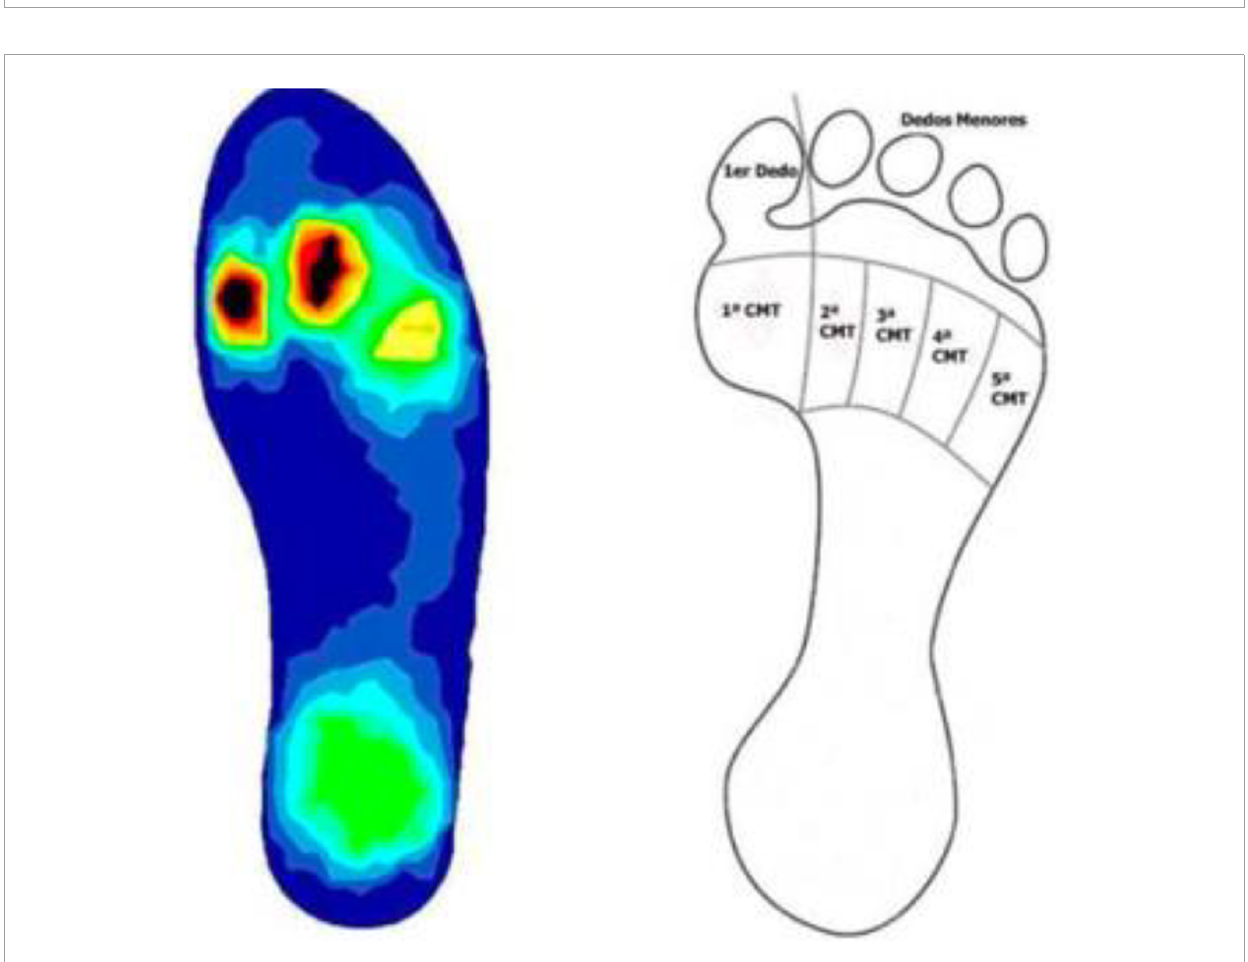
FIGURE5 Forefoot division in the seven zones